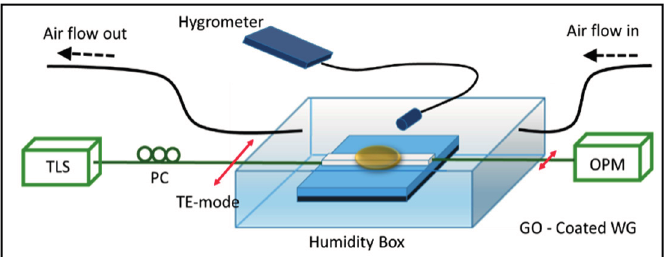
Figure 1. Schematic diagram of the proposed sensor—A GO-coated SU8 polymer waveguide in a humidity measurement